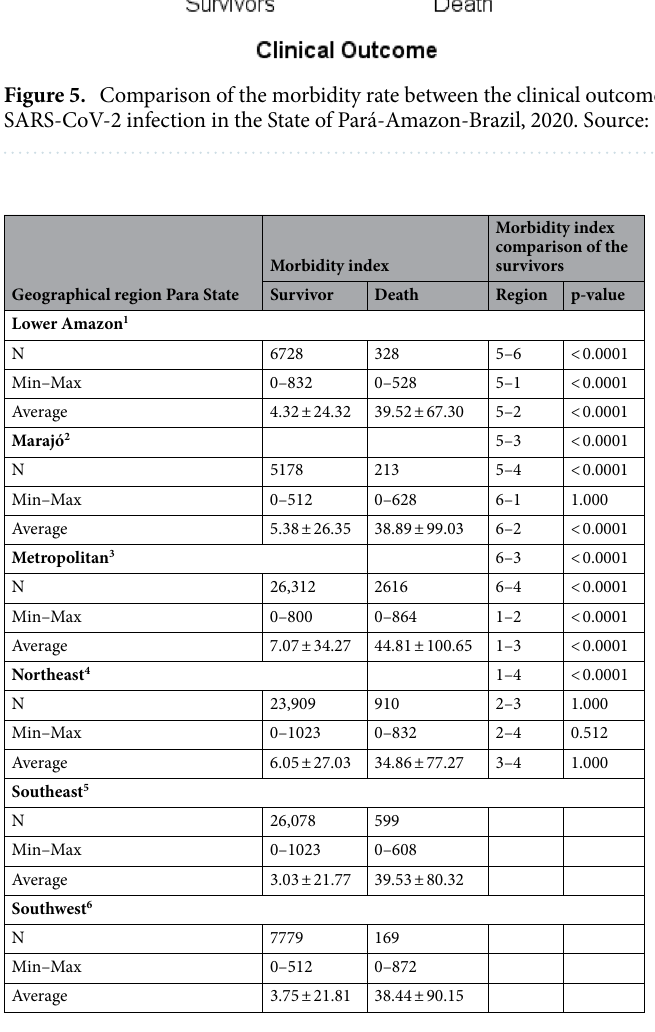
Table 4. Distribution of the morbidity rate in relation to the clinical outcome facing infection by SARS-CoV-2 in the geographic regions of the State of Pará-Amazon-Brazil, 2020. Source: OpenDataSUS, Ministry of